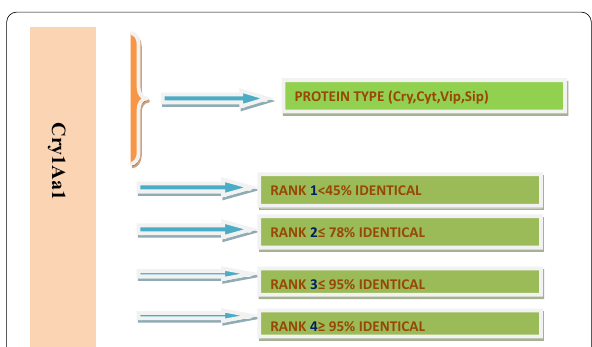
Fig. 1 An outline image of the present nomenclature system employed by the Bacillus thuringiensis toxin Nomenclature Committee for δ-endotoxins and other toxins. The above image illustrates the Cry toxins with four ranked systems assigned by the percentage of amino acid similarity